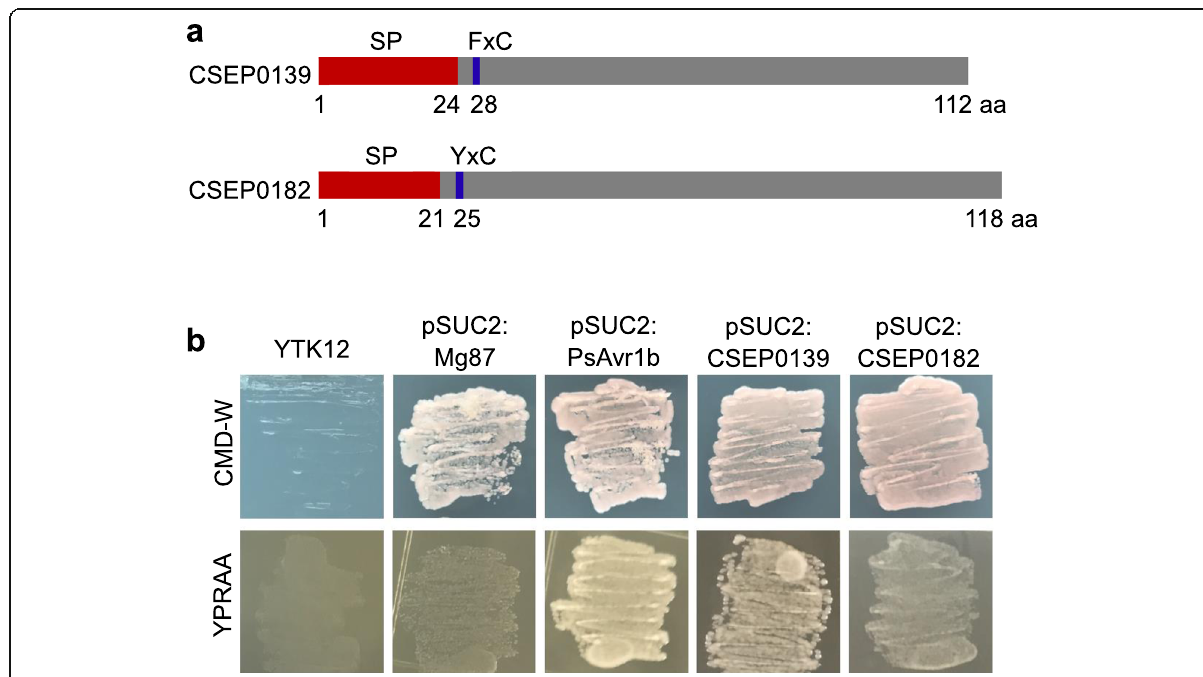
Fig. 1 CSEP0139 and CSEP0182 contain a functional signal peptide. a Schematic representation of CSEP0139 and CSEP0182, the N-terminal signal peptide (SP) was predicted by Signal 4.0 (http://www.cbs.dtu.dk/services/SignalP), highlighted in red. Shades of blue indicate F/YxC motif. b Yeast invertase secretion assay for the verification of SP. The SP sequences of CSEP0139, CSEP0182, and P. sojae Ps Avr1b and the N-terminal sequence of M. oryzae Mg87 were individually fused to yeast invertase lacking its own SP in the pSUC2 vector. CMD-W (minus Trp) media were used to select positive transformants of yeast mutant strain YTK12 carrying the pSUC2 vector. Yeast growth on YPRAA media indicates secretion of invertase. The pictures were taken at 3 days after